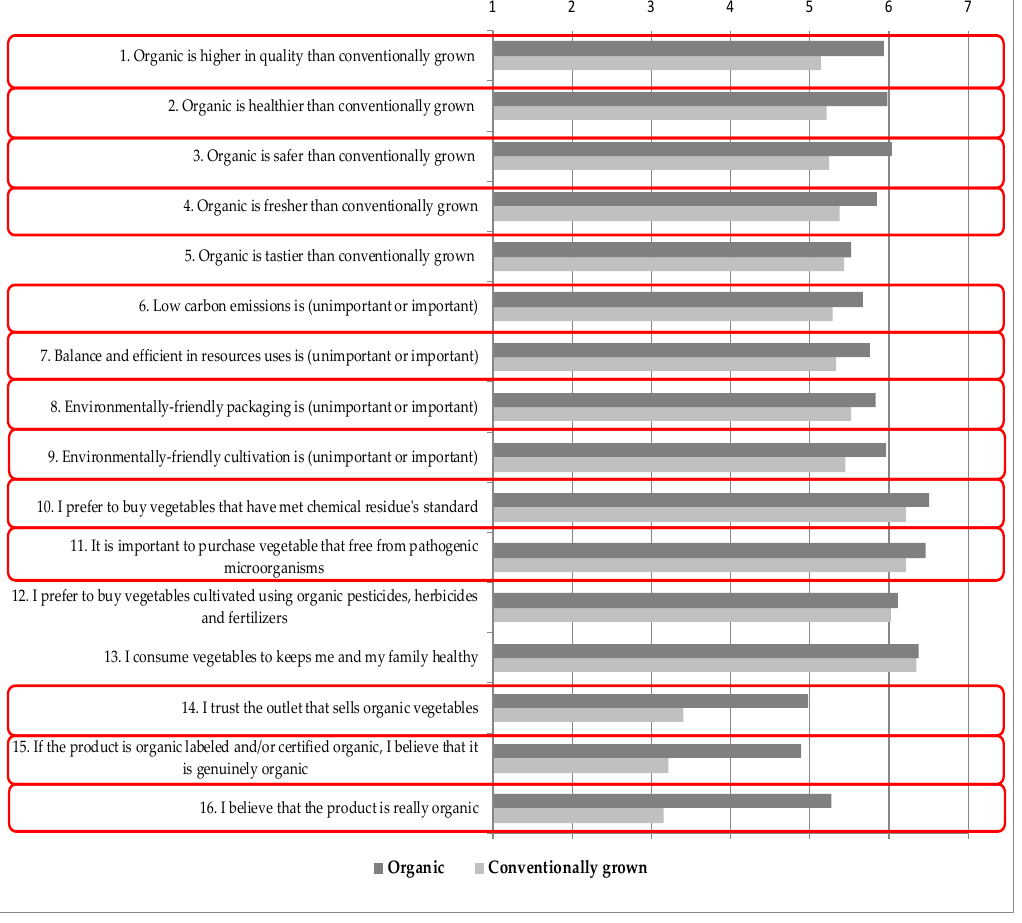
Figure 1. Arithmetic mean values of consumers’ evaluations of statements of the factors driving organic vegetable purchasing; statements with significant differences at the 1% level, based on t -test analysis between both groups, are framed.